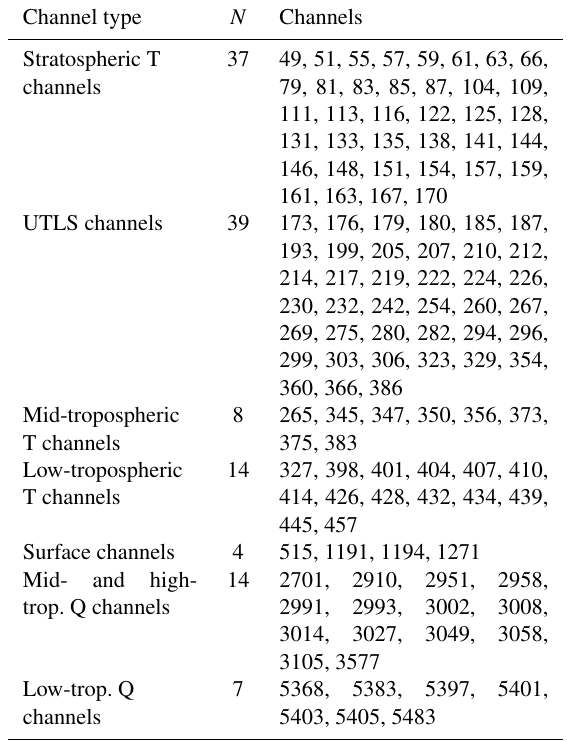
Table 5. List of the 123 IASI channels used for the profile retrievals. Channel